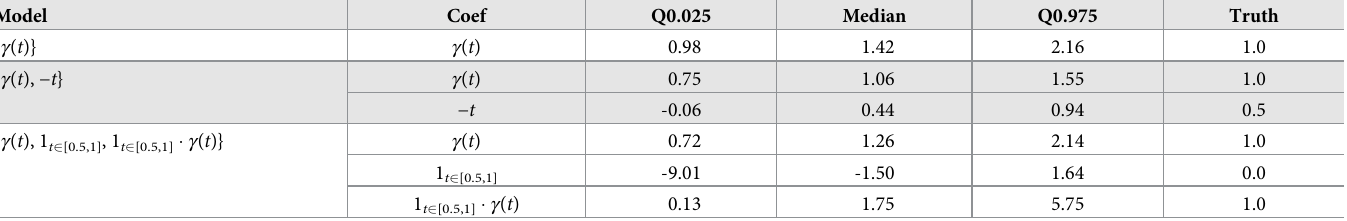
Table 2. Summary of simulated sequence data inference. Posterior distribution quantile summaries for BEAST implementation of BNPR-PS models: with no covariates (model: { γ ( t )}, first row), with an ordinary covariate (model: { γ ( t ), − t }, second and third row), with both an ordinary and interaction covariate (model: { γ ( t ), 1 t 2 [0.5,1] , 1 � γ ( t )}, last three t 2 [0.5,1]